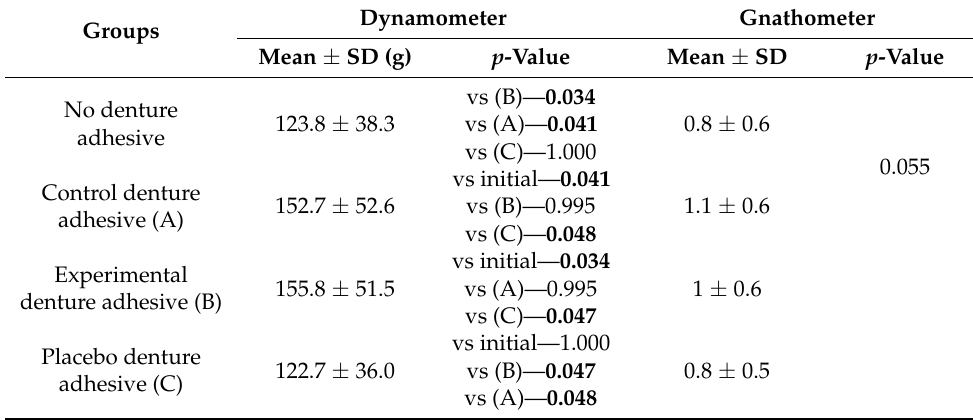
Table 3. Dynamometer and gnathometer